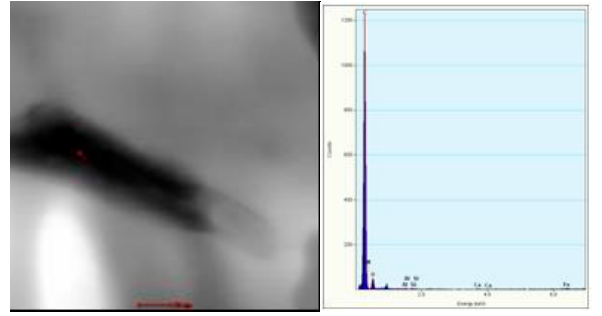
Figure 11. TEM–STEM details of EBS crystallized on HNT structure (sample (HNT-EBS)120).